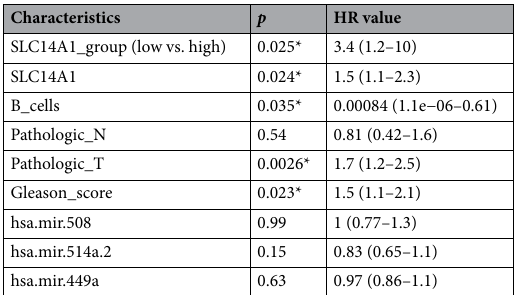
Table 2. Multivariable Cox regression of characteristics relating to BCR events. *Statistically significant (α = 0.05). BCR biochemical recurrence, HR hazard